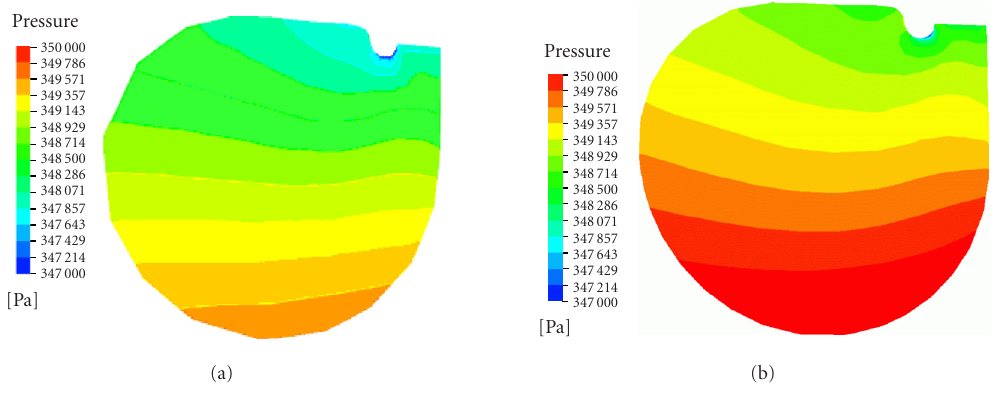
Figure 9: Static pressure contours versus the volute exit ( θ = 180 ◦ ). (a) Sharp tongue. (b) Round tongue, indicating a much less uniform pressure distribution.